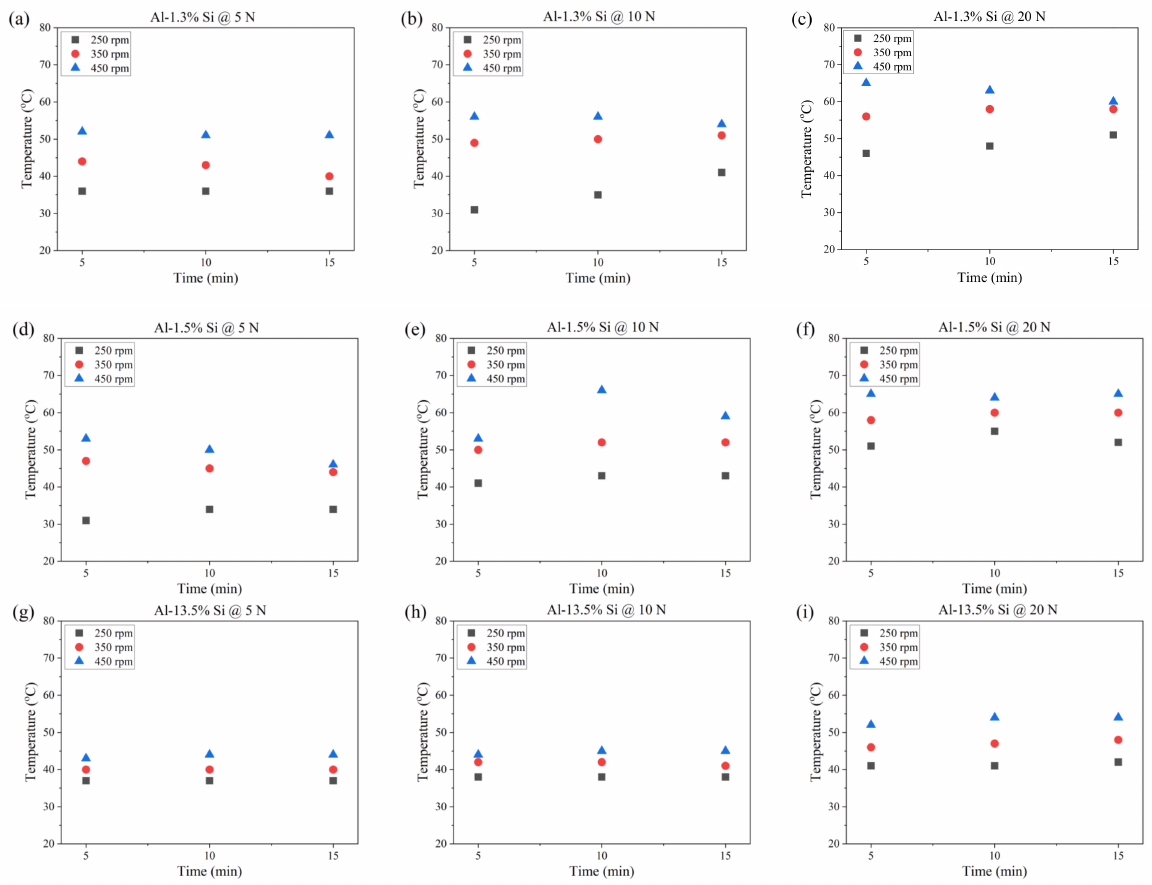
Figure 8. Friction temperature vs. time plots as functions of normal load (5, 10, and 20 N) and rotational